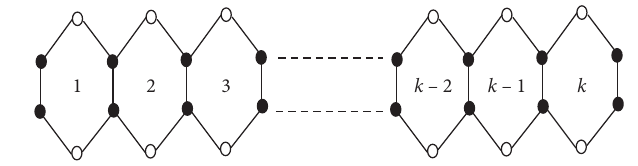
Figure 4: The linear hexagonal chain L